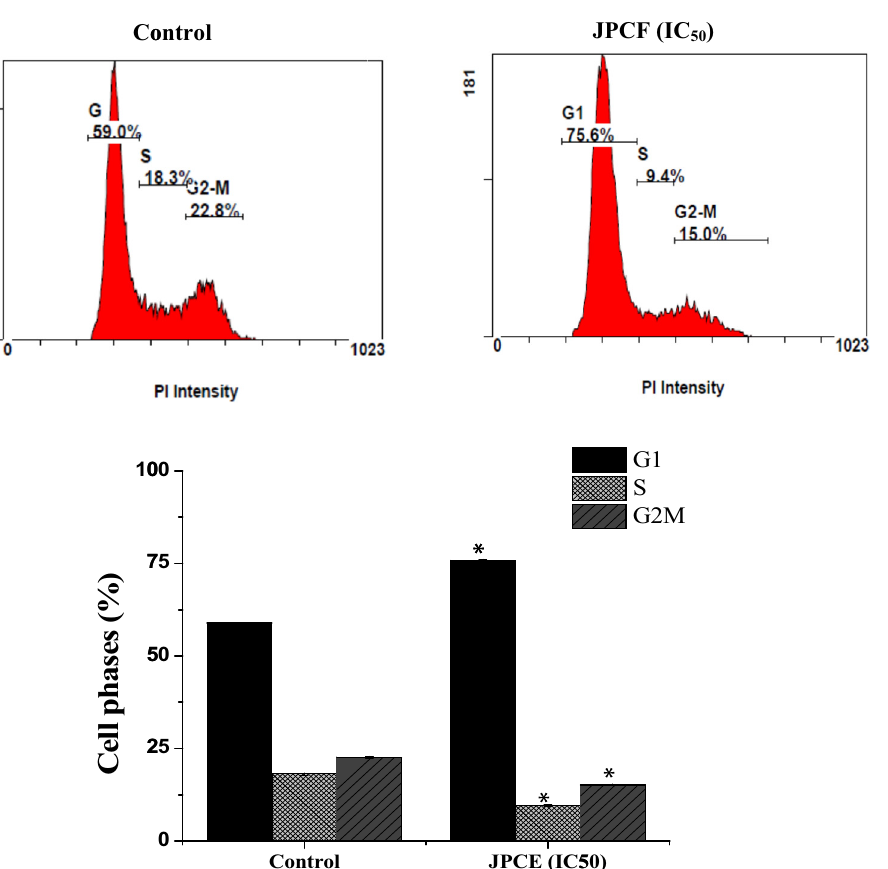
Figure 2: Chloroform fraction of J. phoenicea induces G1 cell cycle arrest in MCF - 7 cells. MCF - 7 treated cells with the test fraction at IC 50 for 24 h and were then stained with PI. Representative histogram that was obtained using a fl ow cytometer where quantitation was obtained from ( a ) . * p ≤ 0.05, ** p ≤ 0.01, or *** p ≤